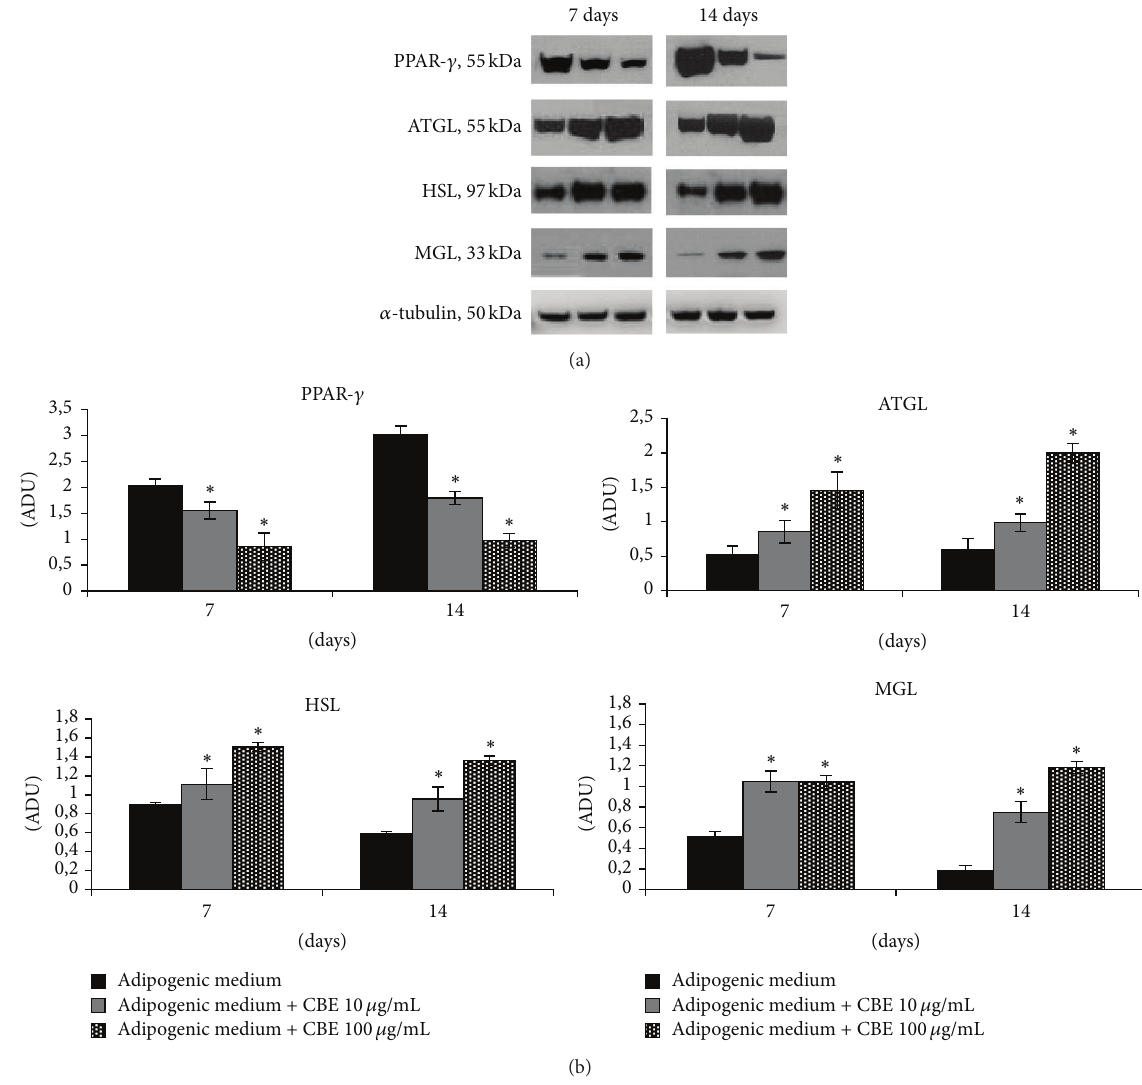
Figure 5: Effects of Citrus bergamia extraction on PPAR- 𝛾 , ATGL, HSL, and MGL: 14-days differentiated adipocytes were treated with 10 or 100 𝜇 g/mL for 7 or 14 days. The levels of proteins are expressed as arbitrary densitometric unit (ADU). Data were shown relative to 14- day differentiated adipocytes (adipocytes) and expressed as mean ± SD from three independent experiments. ∗ 𝑝 < 0.01 versus the 14-day differentiated adipocytes